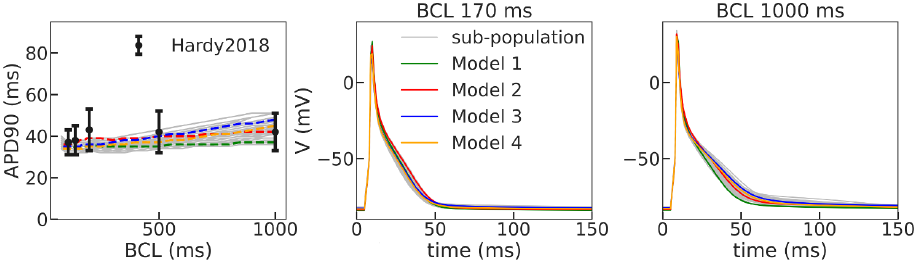
Figure A1. Restitution curves and action potential signals from a sub-population of 39 cellular models consistent with experimental data from Hardy et al. [27] used for model selection. Four representative models from the sub-population were arbitrarily selected for analysis and used in tissue simulations. Restitution curves for the four selected models (colored lines) lie within the curve band for the sub-population (gray lines). The time-dependent AP signals are also within the compact corridors of signals for the other models of the family.